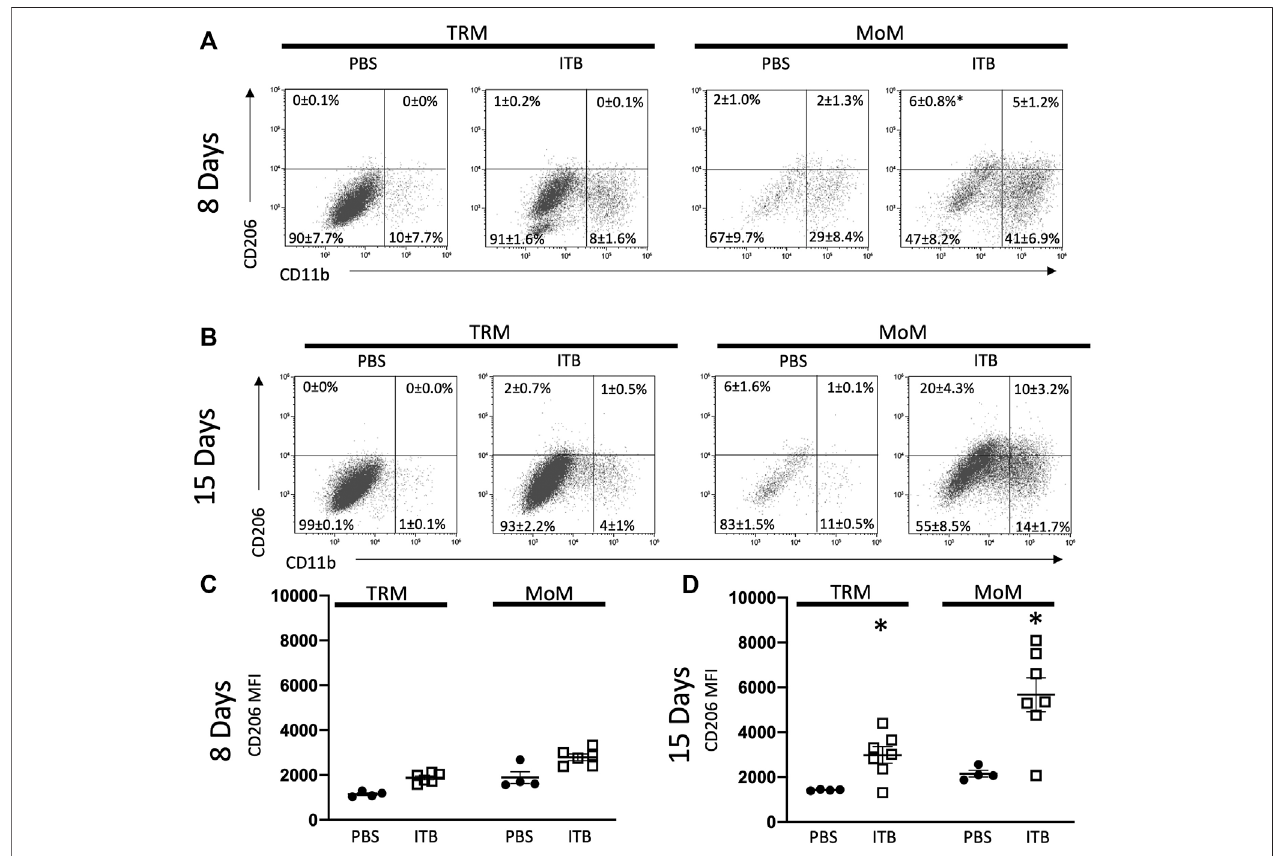
FIGURE 4 | TRM and MoM populations increase CD11b and CD206 expression post ITB. (A – B) TRM and MoM expression of CD206 and CD11b at 8 (A) and 15 (B) dayspostinstillationinrepresentativeplots.Themeanpercentages±SEforeachquadrantarereported. (C – D) CD206expressionreportedasmean fl uorescence intensity (MFI) of TRM and MoM populations at 8 (C) and 15 (D) days post ITB. ( n = 4 – 7 per group) * p < 0.05 compared to